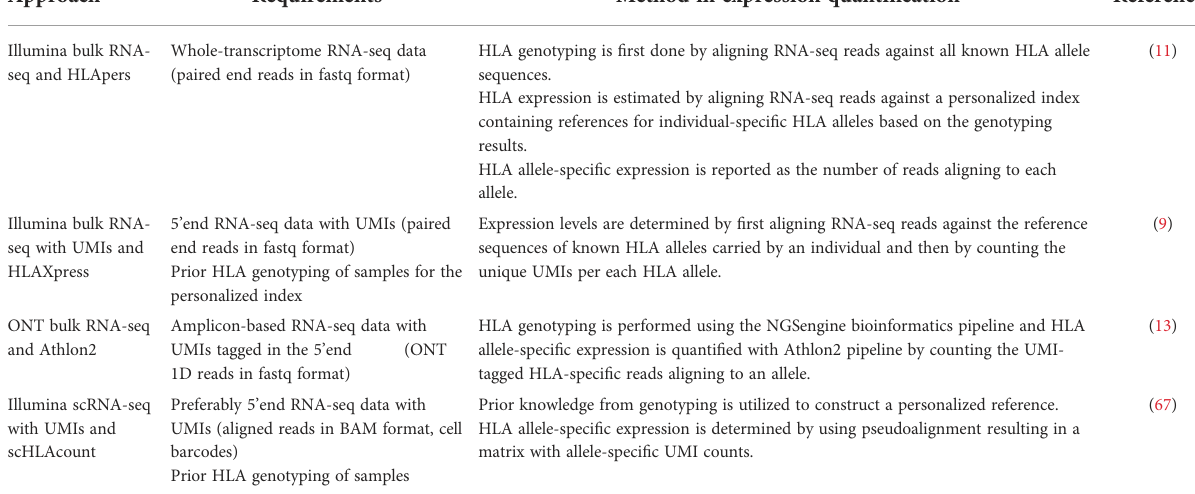
TABLE 2 Examples of different approaches in HLA allele-level expression quanti fi